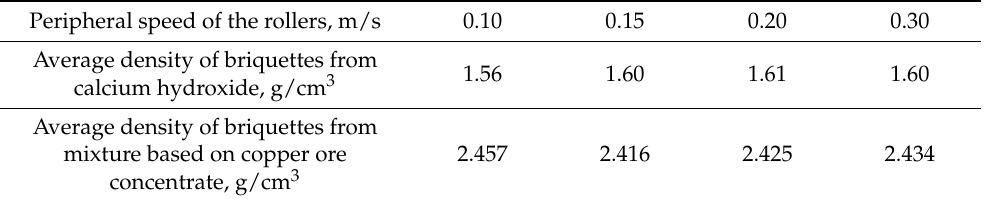
Figure 8. The dependence of power consumption on the peripheral speed of the rollers when bri- quetting: ( a )—calcium hydroxide; ( b )—mixture based on copper ore concentrate. Table 4. The dependence of the average density of briquettes on the peripheral speed of the rollers. Peripheral speed of the rollers, m/s 0.10 0.15 0.20 0.30 Average density of briquettes from calcium hydroxide, g/cm 3 Average density of briquettes from mixture based on copper ore concentrate, g/cm 3